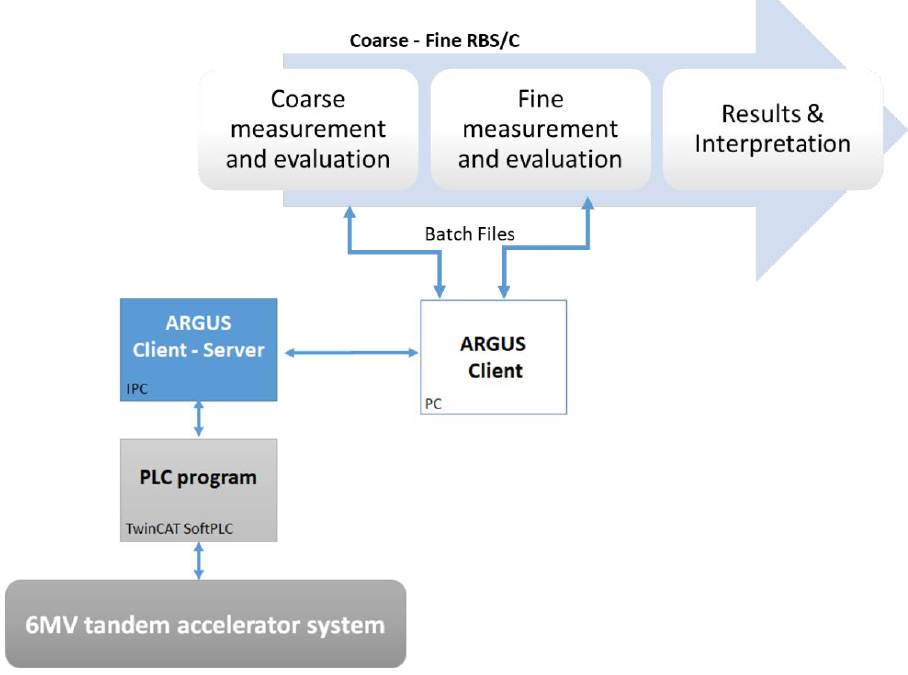
Figure 6. Software architecture of designed system with MATLAB application.